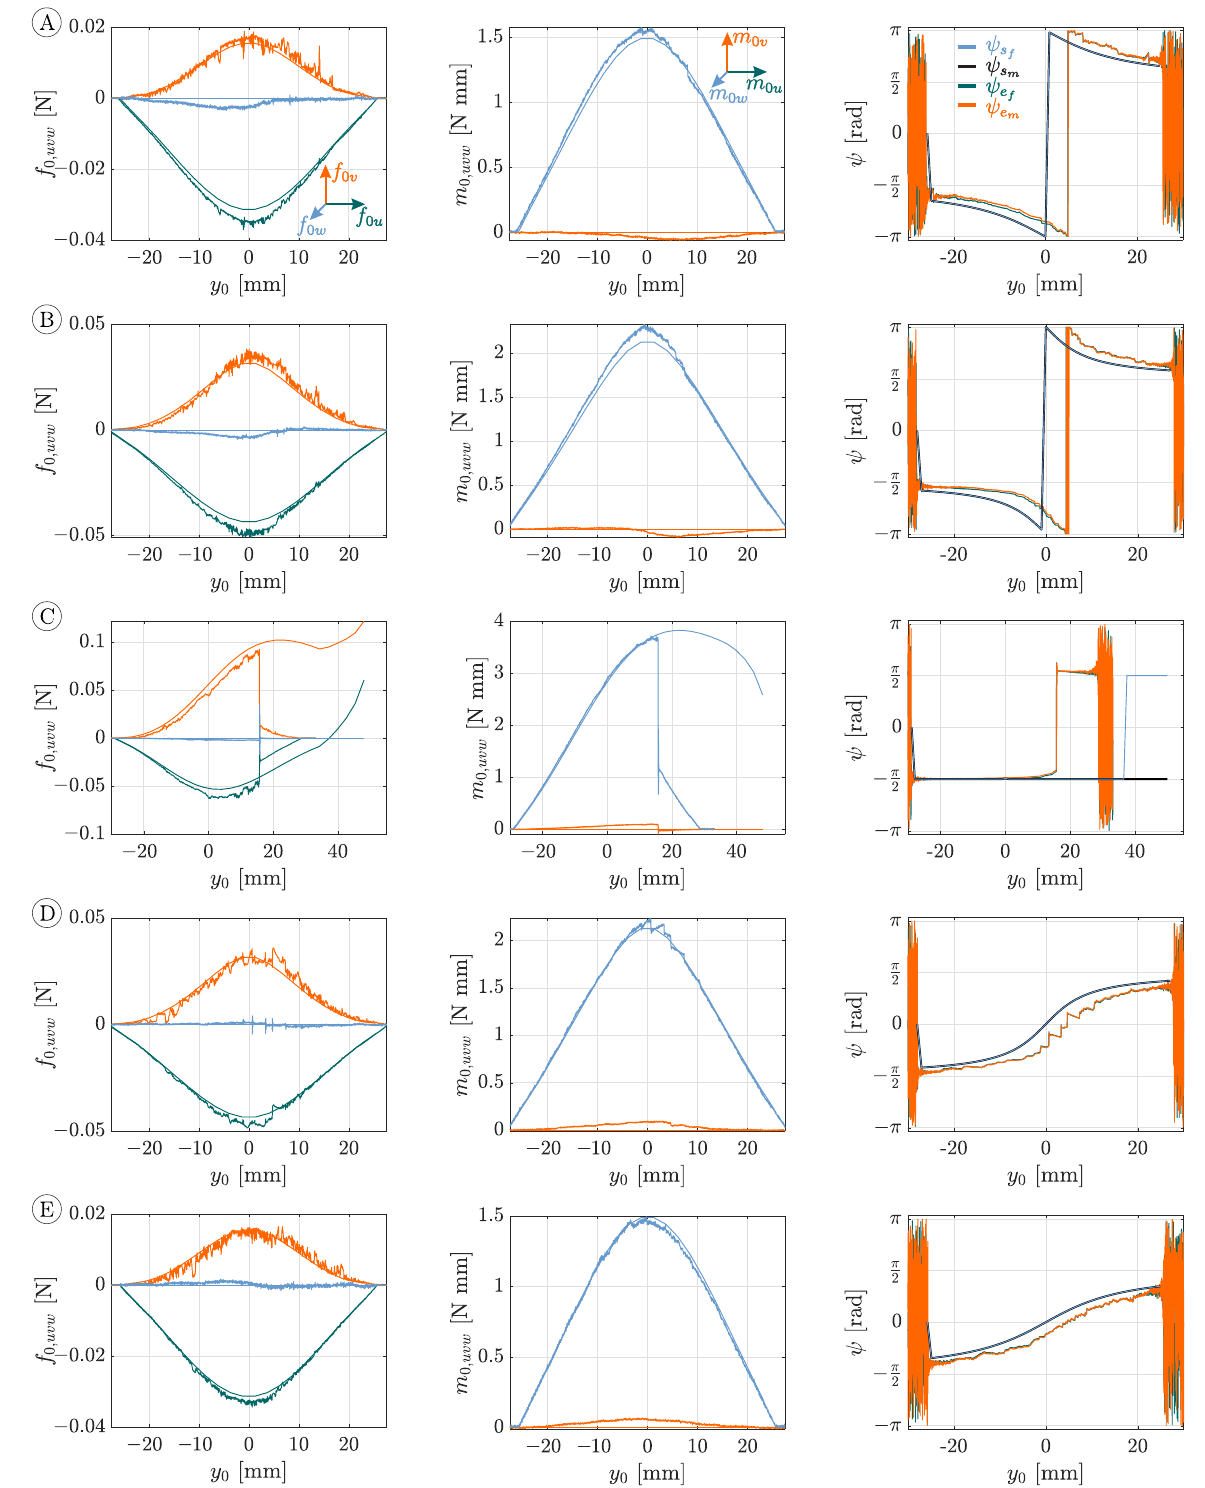
Figure 11. Simulated and measured observables, represented by smooth and noisy data, respectively, during object scanning of a 60 mm glass sphere. Each row results from object scanning according to the scanning sweeps ( A – E ) schematically shown in Figure 7 and includes the following diagrams: reaction forces on the left, reaction moments in the middle and orientation angle ψ of the deformation plane calculated using Equation (23) on the right ( ψ s based on the simulated reaction f forces in blue, ψ s based on the simulated reaction moments in black, ψ e based on the measured reaction forces in green m f and ψ e based on the measured reaction moments in orange). Note that, for the y 0 - ψ -diagram, both the green and orange m curves, as well as the black and blue curves, almost coincide and, therefore, obscure each other to a large